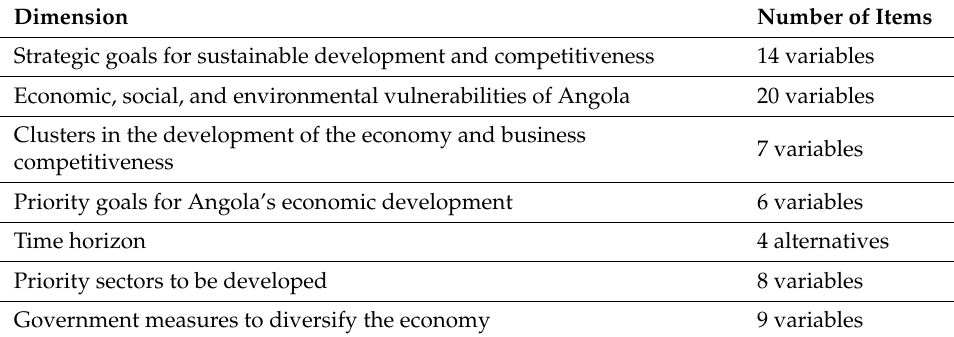
Table 2. Dimensions and items used in the questionnaire. Dimension Number of Items Strategic goals for sustainable development and competitiveness 14 variables Economic, social, and environmental vulnerabilities of Angola 20 variables Clusters in the development of the economy and business competitiveness Priority goals for Angola’s economic development Time horizon Priority sectors to be developed Government measures to diversify the